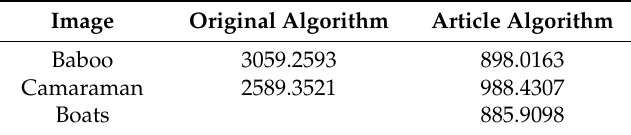
Table 3. Time (ms) taken during